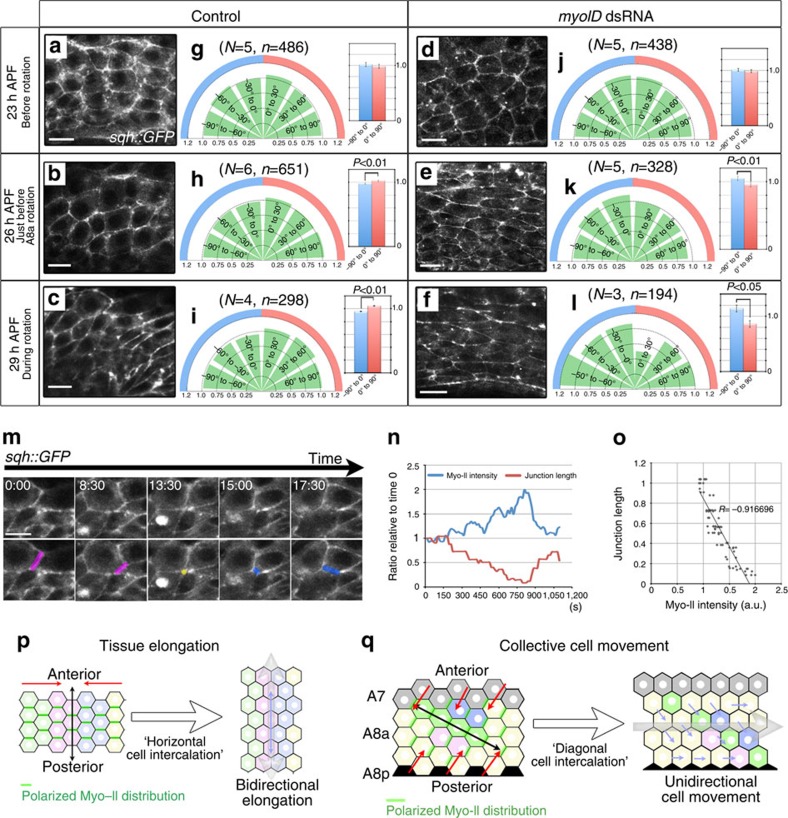
LR asymmetric Myo-II accumulation in A8a epithelial cells.(a–f) Myo-II protein observed by the GFP fluorescence of sqh::GFP in control (a–c) and myoID dsRNA-expressing flies (d–f), at 23 h APF (a,d), 26 h APF (b,e) and 29 h APF (c,f). Scale bar, 10 μm. (g–l) Rose diagrams showing the mean of the normalized sqh::GFP fluorescence intensities at cell boundaries in the A8a of control (g–i) and myoID knockdown flies (j–l), at 30° intervals of angle θ, at 23 h APF (g,j), 26 h APF (h,k) and 29 h APF (i,l). Right, histograms showing the mean of normalized intensities representing the indicated ranges of angle θ, and error bars indicating s.d. Number of flies, N; number of cell boundaries, n. (m–o) Cell intercalation tracked by sqh:GFP expression. The junction length (red) and Myo-II intensity (blue) are shown in n, and the inverse correlation between junction length and Myo-II intensity is plotted in o. Scale bar, 10 μm. Fly genotypes: sqhAX3/Y; sqh::GFP (a-c, g-i, and m-o), sqhAX3/Y; sqh::GFP; AbdB-GAL4/UAS-myoID dsRNA (d–f and j–l). (p,q) Schematic of germ-band elongation (p) and our model of collective cell migration (q), which are both mediated by cell intercalation. Red arrow: direction of contraction; black arrow: direction of elongation; green line: Myo-II distribution; blue arrow: direction of cellular movement; grey arrow: direction of global cellular flow.